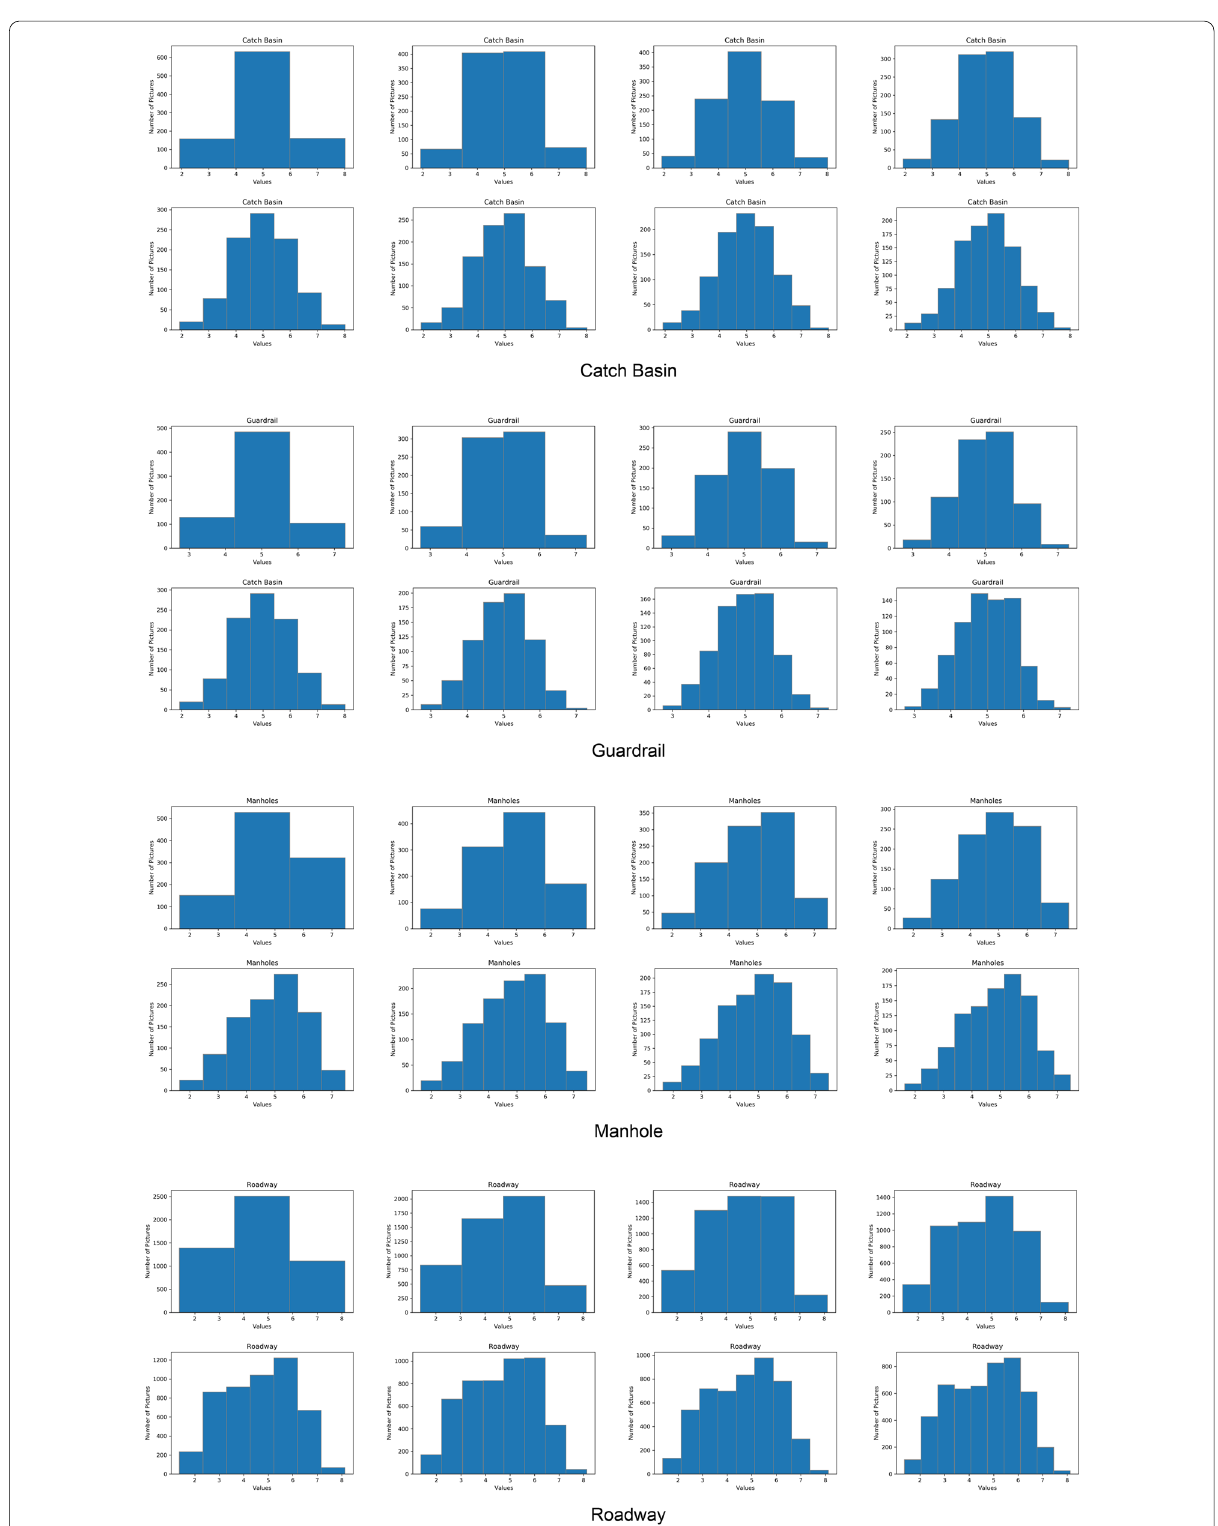
Fig. 23 Q-score histograms of 4 facilities with different group numbers (3 To